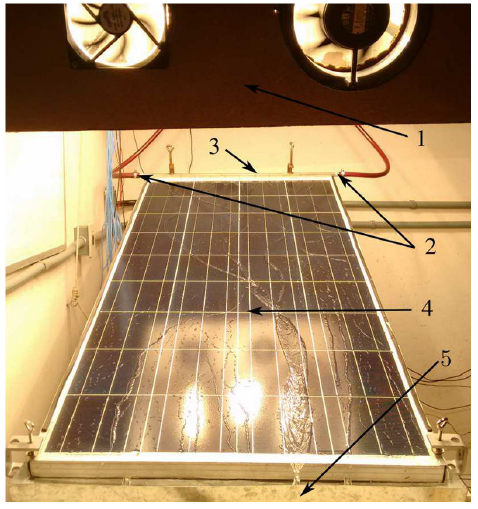
Fig. 3. Developed laboratory